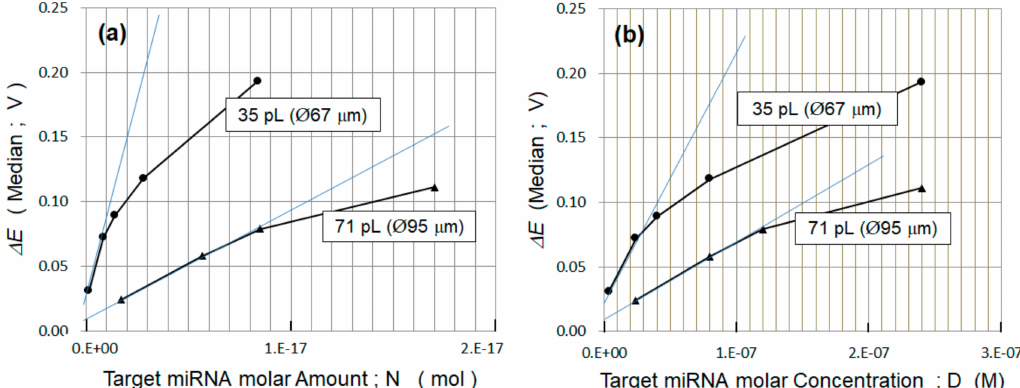
Figure 7. ( a ) The median values of the complementary system (N3 / R3) in Figure 6a,b are plotted against the molar amount, N , on the linear scale, which is then ( b ) replotted against the molar concentration, D , on the linear scale. The highest ∆ E detection sensitivity for the molar amount and concentration was 140 zmol and 4 nM, respectively, for the 35-pL